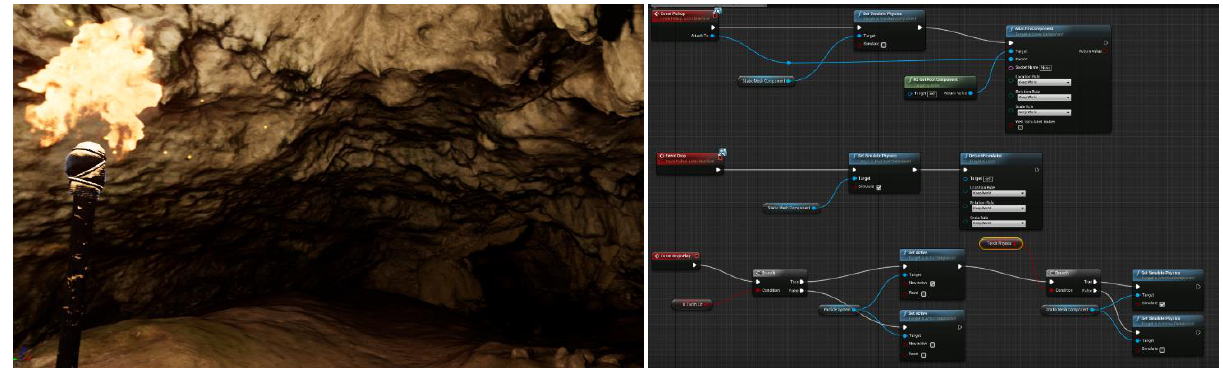
Figure 10. On the left, view of the virtual reconstruction of the cave (taken from Unreal Engine). On the right, the node-based system of Unreal Engine used to obtain the interaction with the